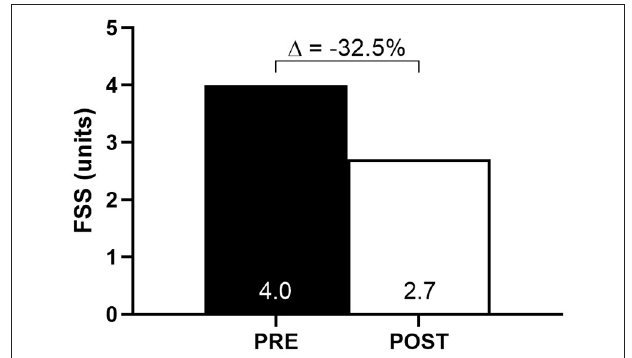
FIGURE 3 | Fatigue severity scale (FSS) score at baseline (PRE) and after 10-week of HBET